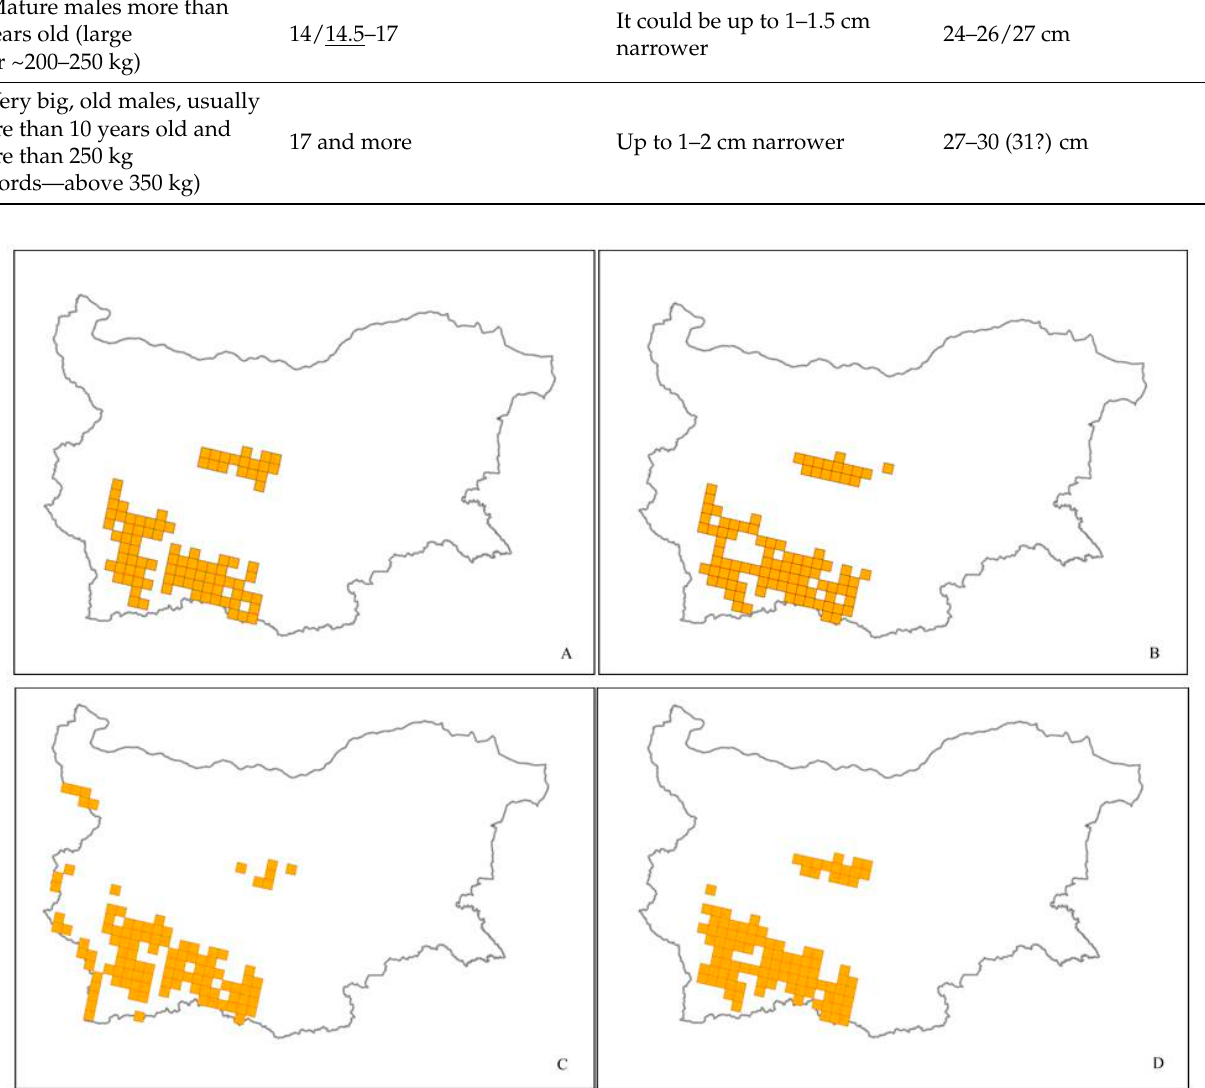
Figure 2. Territory from the national field monitoring of the bear in the main habitats of the species in Bulgaria, distributed in trial areas with a surface of 10 × 10 km. (( A – D ) show the monitoring areas for 2017–2020, respectively).